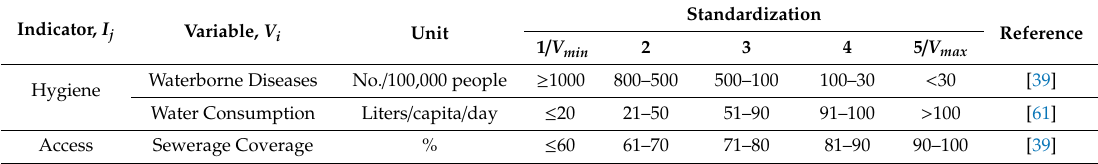
Table 3. Benchmarking variables for sanitation and health